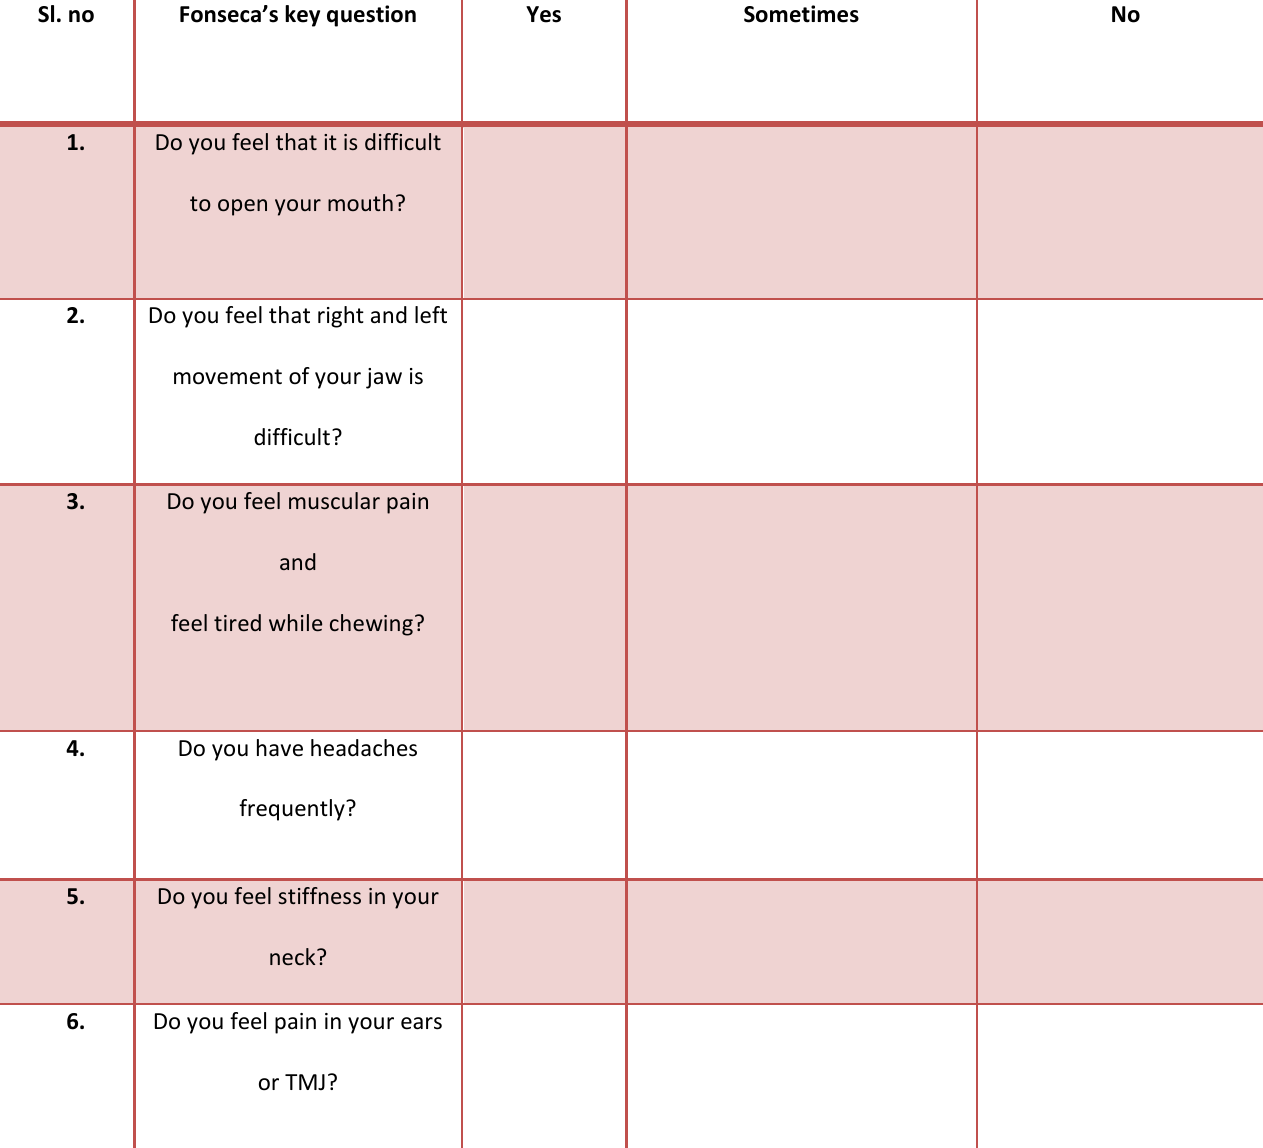
Table 1 - Fonseca’s questionnaire - Key questions in Fonseca’s questionnaire and classification of